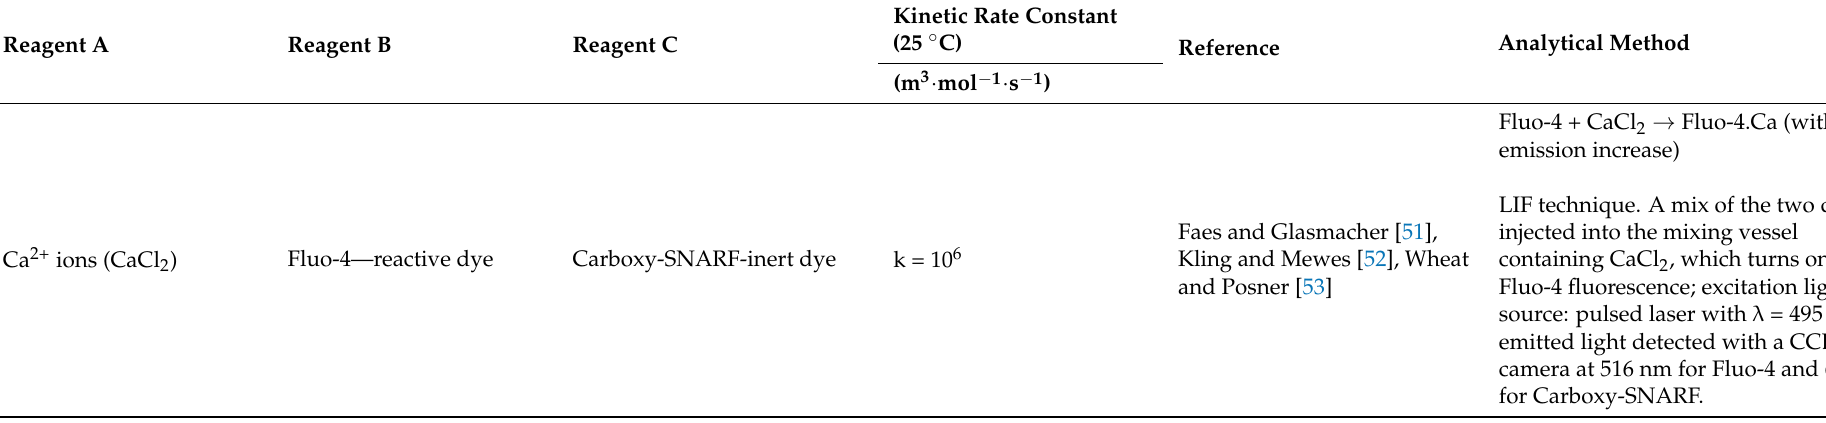
Table 3. Operational parameters for several luminescence methods for assessing